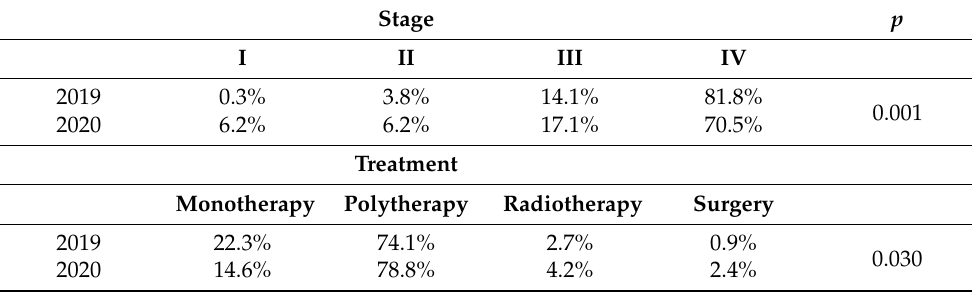
Table 3. Tumor stage and treatment of patients included in the